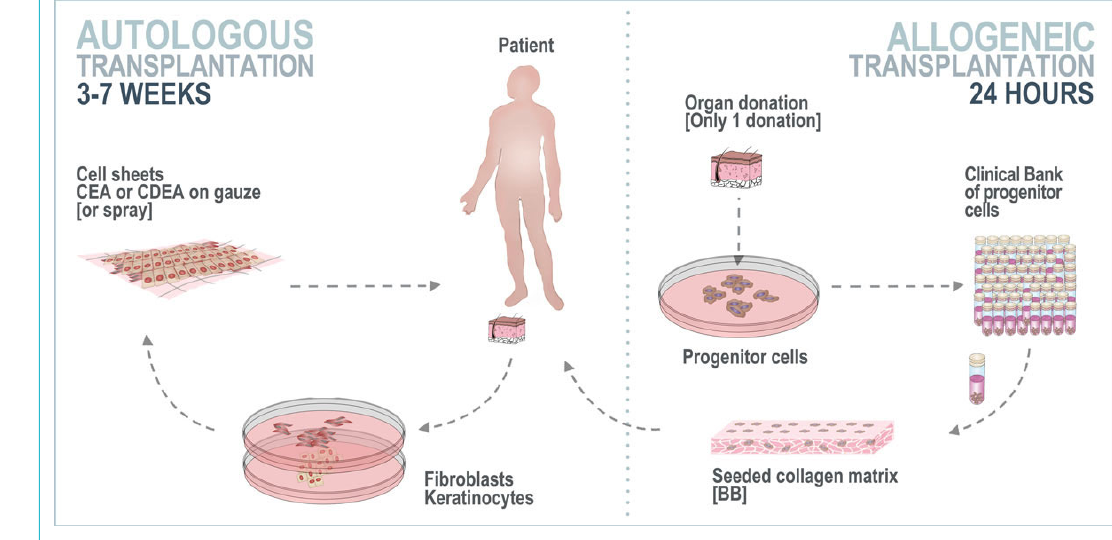
Figure 3: Autologous and allogeneic cell therapy performed at the CHUV Burn Centre. Cell culture is required for each patient for autologous transplants, whereas for an allogeneic transplant, a single organ donation creates a cell bank that can treat multiple patients and significantly reduce the time-to-treatment. CEA = cultured epithelial autograft; CDEA = cultured dermal-epithelial autograft; BB = biological